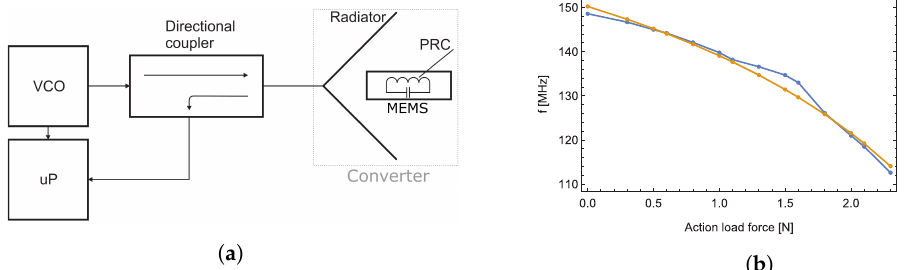
Figure 4. Block diagram of sensor, for our previous measurement and evaluation method ( a ) Transfer characteristic between applied force and the resonant frequency of converter , measured with the use of previously published method (yellow—theory, blue—measurement) ( b ) [9]